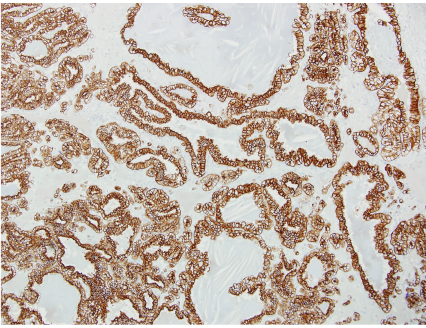
Figure 2: Low power showing dominant tubular architecture.